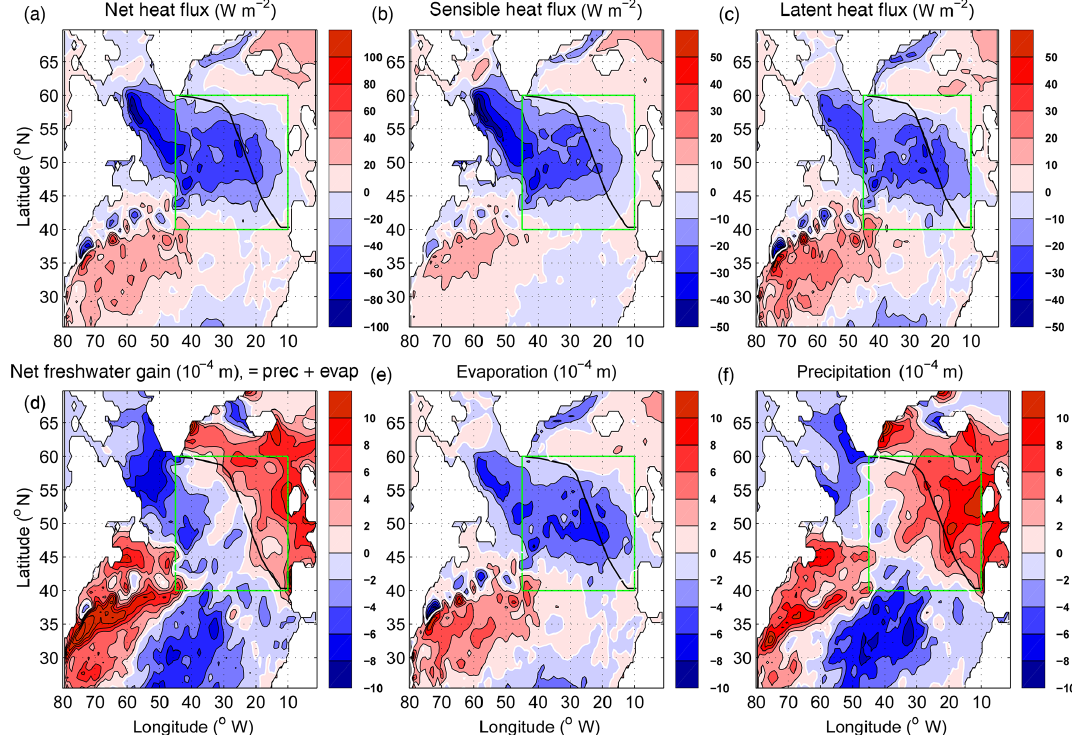
Figure 11. The 2014 winter–spring (DJFMAM) mean anomalies. The anomalies were calculated with respect to the period 2002–2012. Panels (a) , (b) , and (c) are the total heat, sensible heat, and latent heat air–sea flux, respectively, in Wm − 2 ; positive or negative values indicate ocean heat gained or lost. Panels (d) , (e) , and (f) are net gain of freshwater, evaporation, and precipitation; the unit is 10 − 4 m; positive or negative values indicate ocean freshwater gain or loss. The contours of anomalies 0Wm − 2 (in a , b , and c ) and of 0m (in d , e , and f ) are represented by a white line. Data source: ERA-Interim. The green square represents the area for which the changes in heat and freshwater content and the integrated air–sea heat and freshwater flux represented in Fig. 12 were